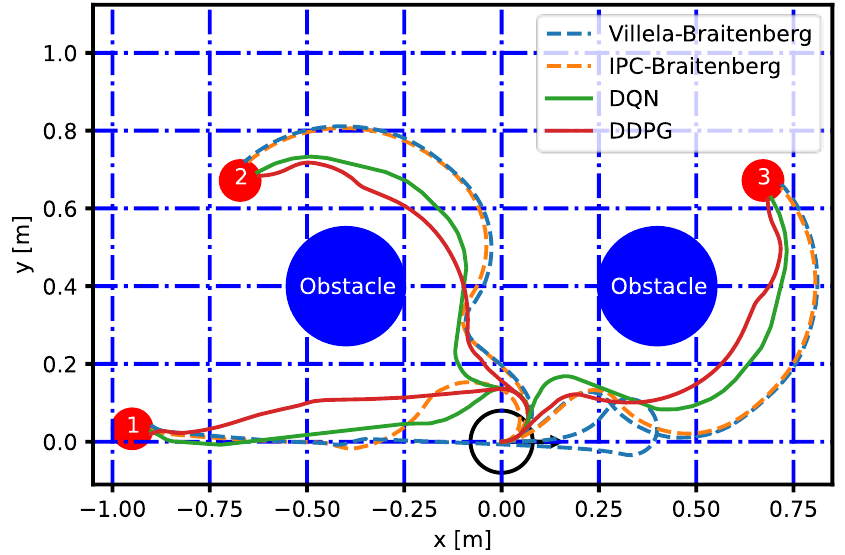
Figure 14. Graph of the trajectory for the three target points in the environment with obstacles.